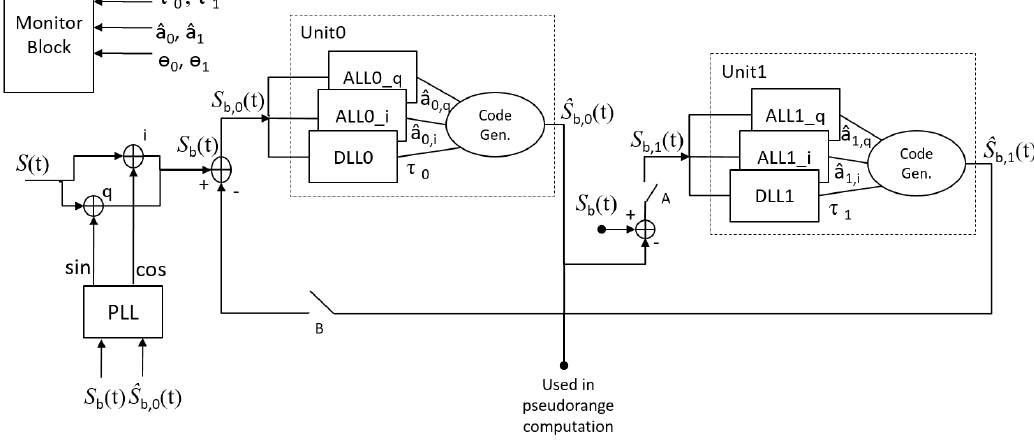
Figure 1. Extended Coupled Amplitude Delay Lock Loop (ECADLL) architecture for a single GNSS channel and configured for spoofing